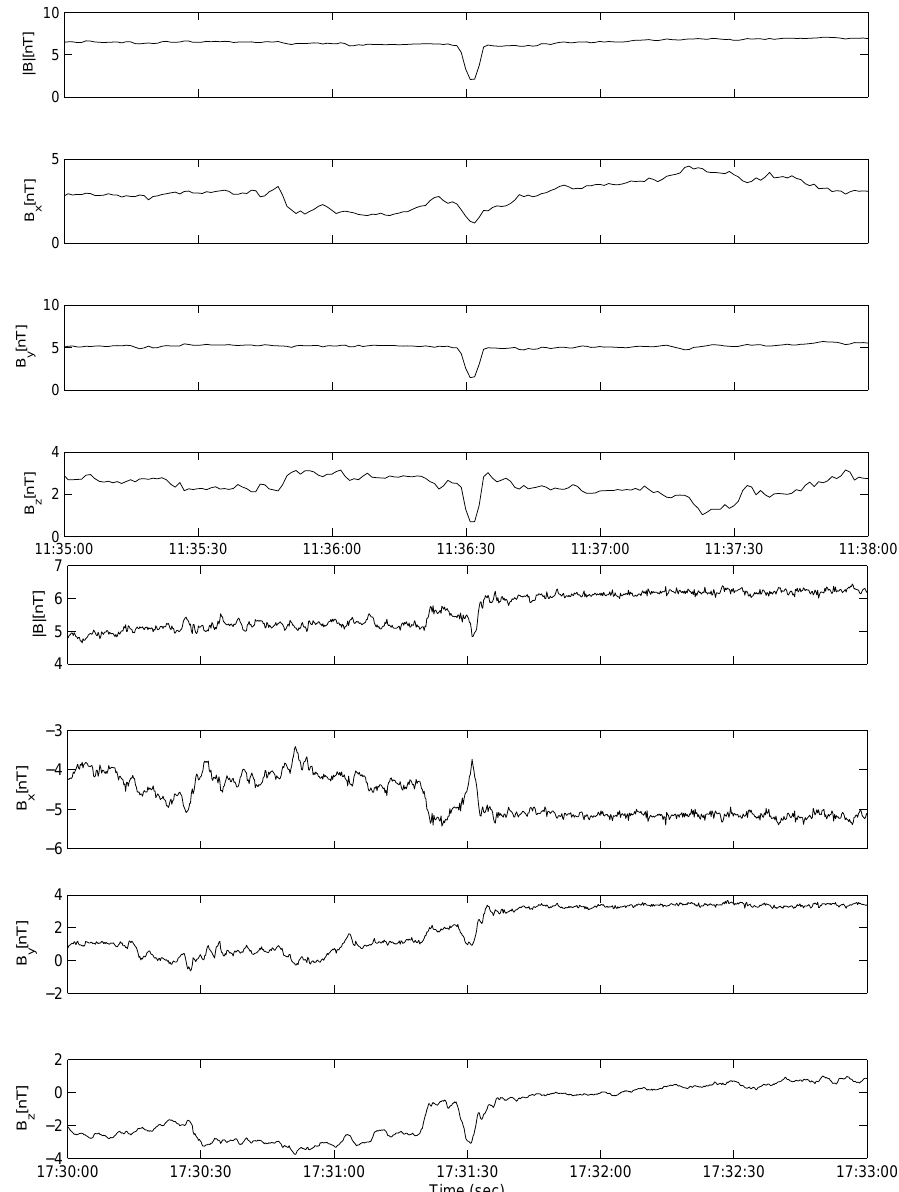
Fig. 1. Magnetic holes observed by Venus Express (top panel) and Cluster C1 (bottom panel). Each panel is 3min long showing time of the